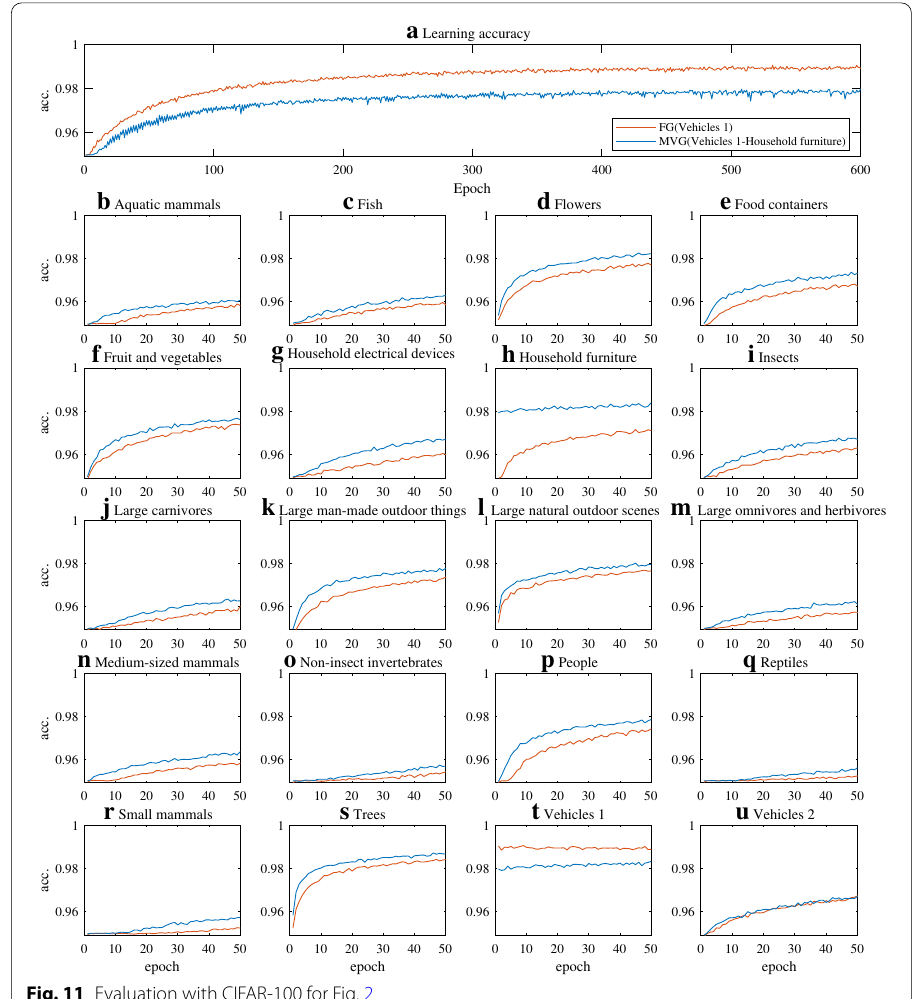
Fig. 11 Evaluation with CIFAR-100 for Fig.